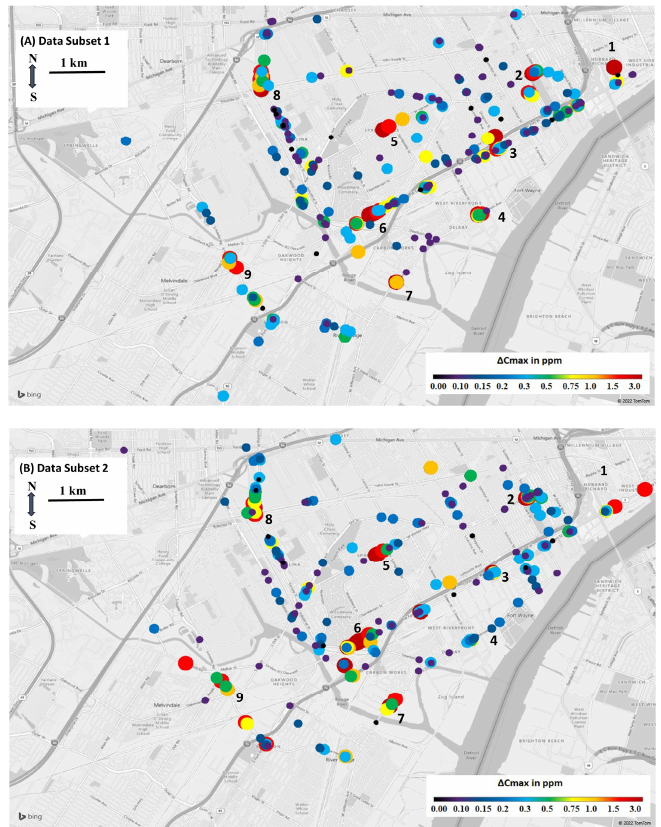
Figure 7. Maps showing Δ C max for ( A ) data subset 1 (280 peaks detected) and ( B ) data subset 2 (254 peaks detected). Maps use parameter set 4; numbers indicate “hotspot” area. Maps represent an 8 × 12 km area.